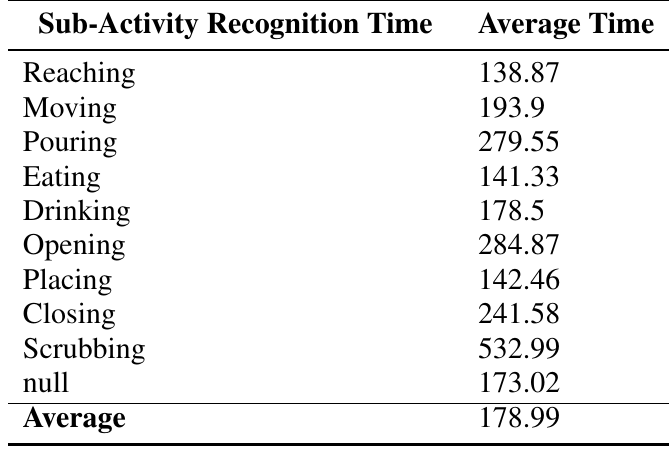
Table 7. Average recognition times (in milliseconds) per